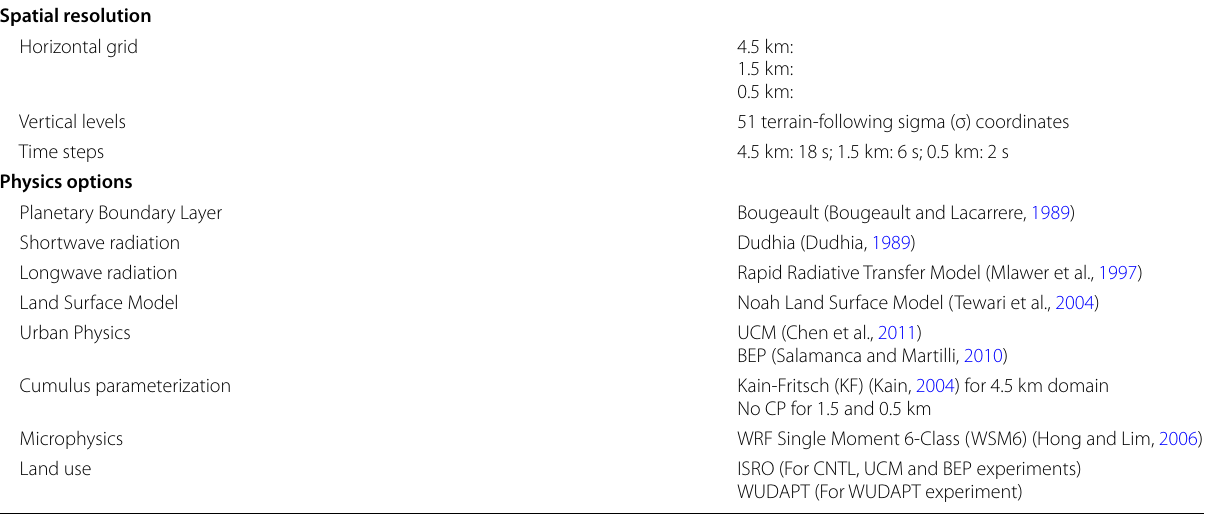
Table 1 Experimental setup used for the current study Spatial resolution